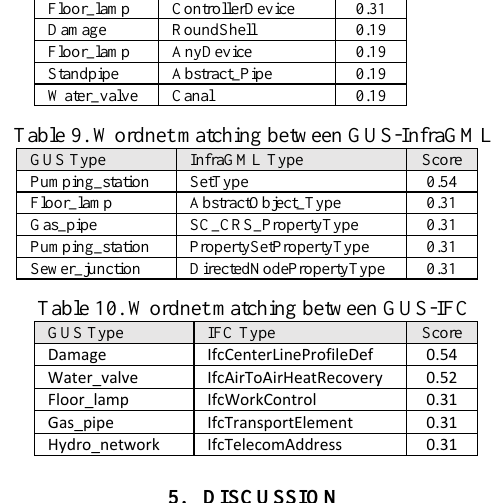
Table 8. Wordnet matching between GUS-NetworkComponents GUS Type Network ADE Type